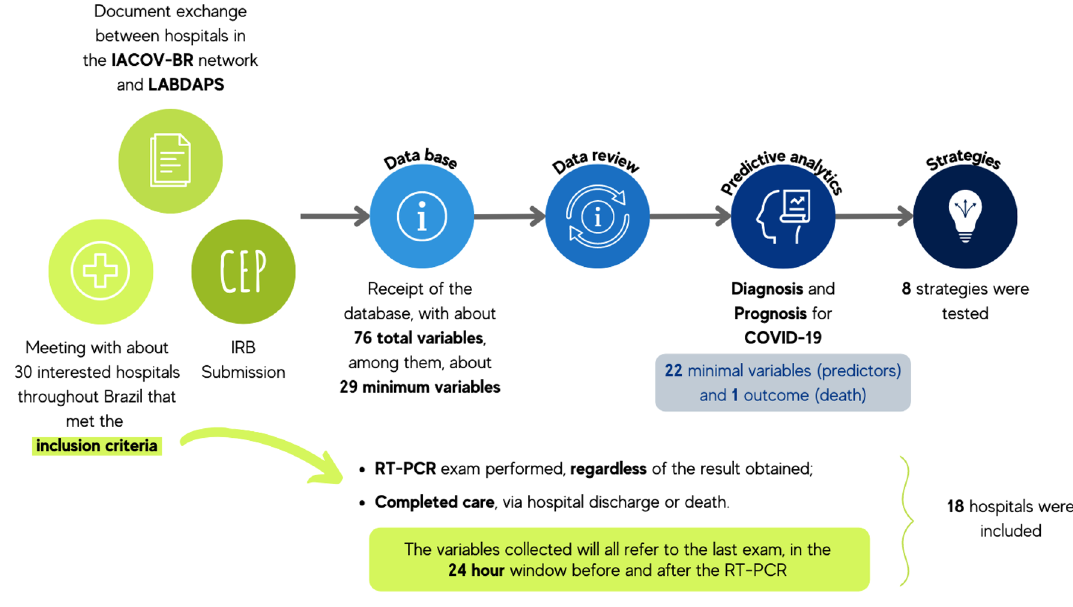
Figure 3. Process overview. From inclusion criteria to feature selection.